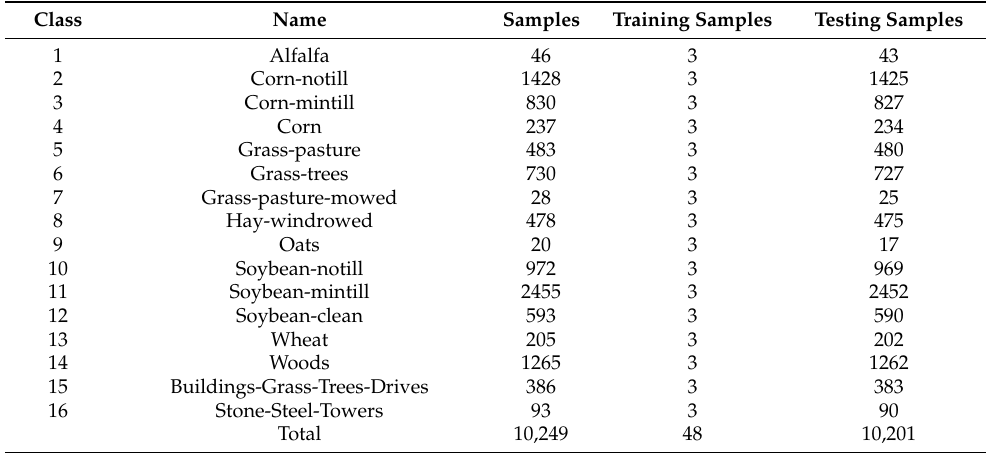
Table 1. Land cover classes and the numbers of samples in the IP data set.